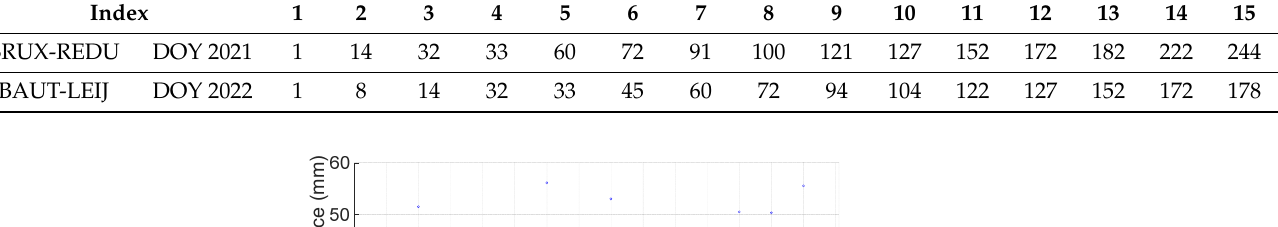
Figure 14. Daily maximum ZPD difference of the two baselines on selected days.